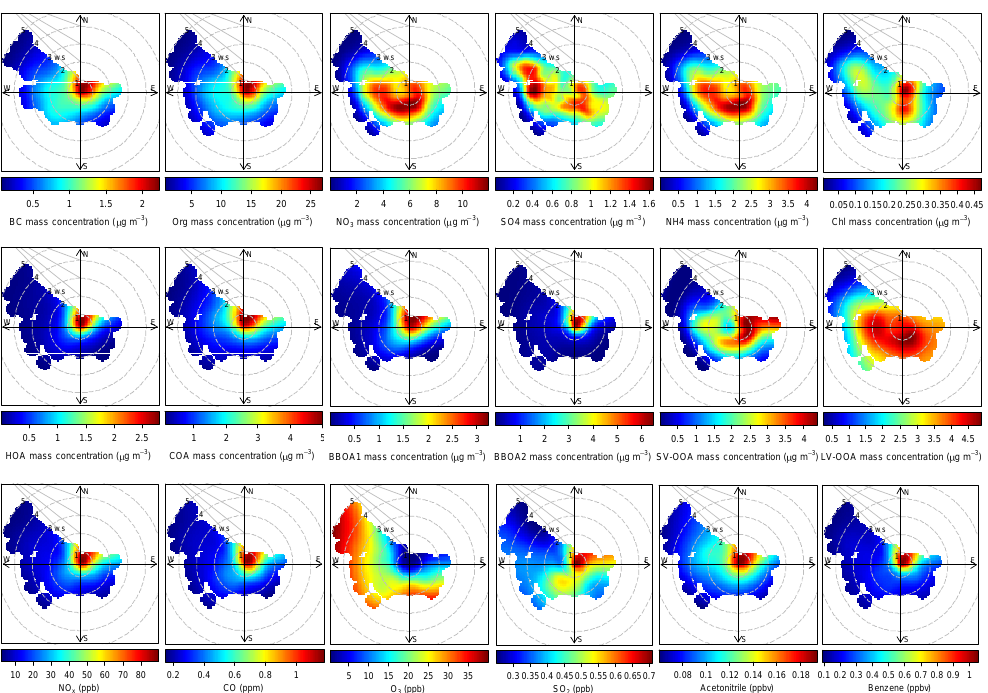
Figure 7. Polar plots of hourly averaged PM 1 species concentrations (top row), mass concentrations of the six OA factors identified from PMF analysis (middle row), and mixing ratios of various gas-phase species from the CARB monitoring station as well as acetonitrile and benzene VOCs measured by the PTR-TOF-MS (bottom row) as a function of wind speed and direction. These polar plots were plotted in R using the openair package (Carslaw and Ropkins, 2012; Carslaw, 2015), a data analysis tool for investigating air